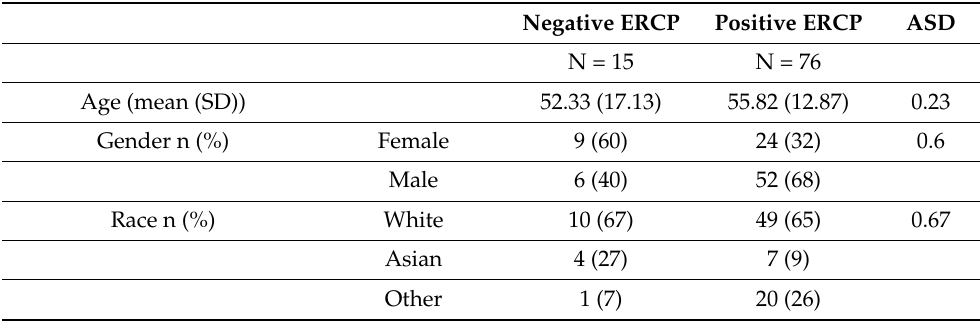
Table 3. Demographics and clinical characteristics of patients who underwent ERCP stratified by ERCP positive vs ERCP